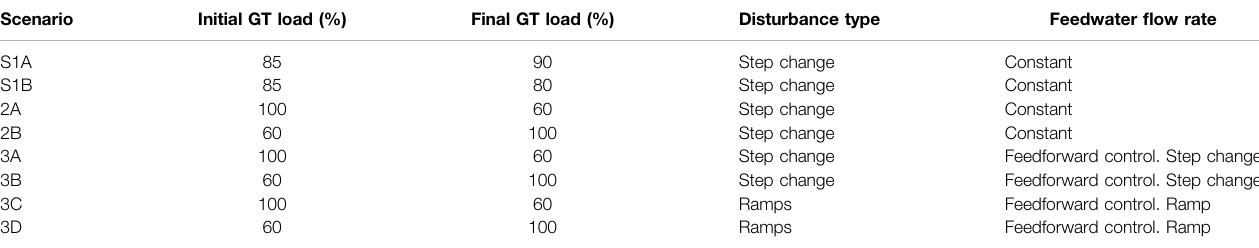
TABLE 4 | Summary description of scenarios for dynamic analysis of OTSGs driven by GT load change.